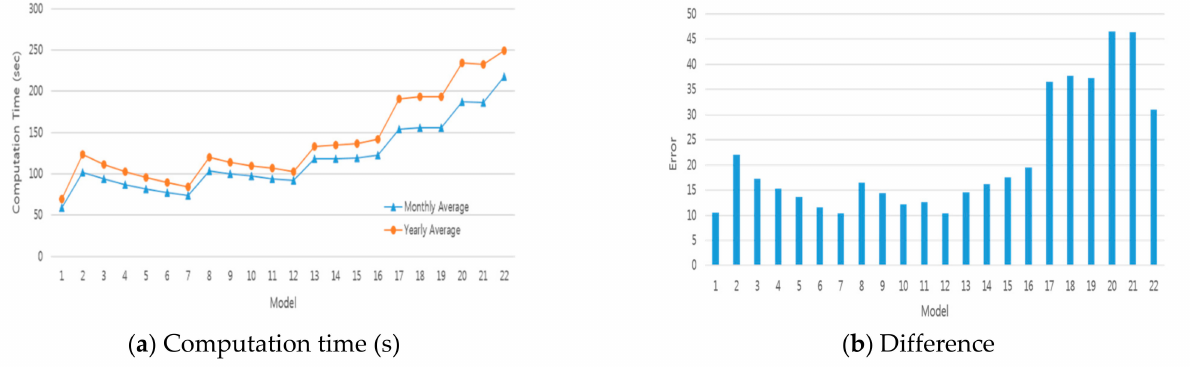
Figure 13. Comparison between the monthly and yearly averages according to the computation time and differences determined by the